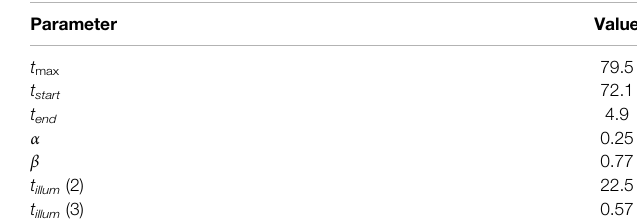
TABLE 4 | Parameters of the optimized 6-oscillator network.